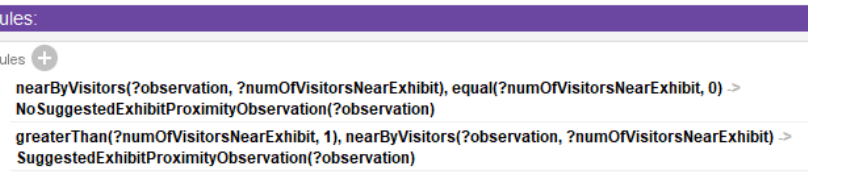
Figure 5. Scenario 2-based SWRL rules in SmartMuseumOnto (depicted in Protégé 5.5).